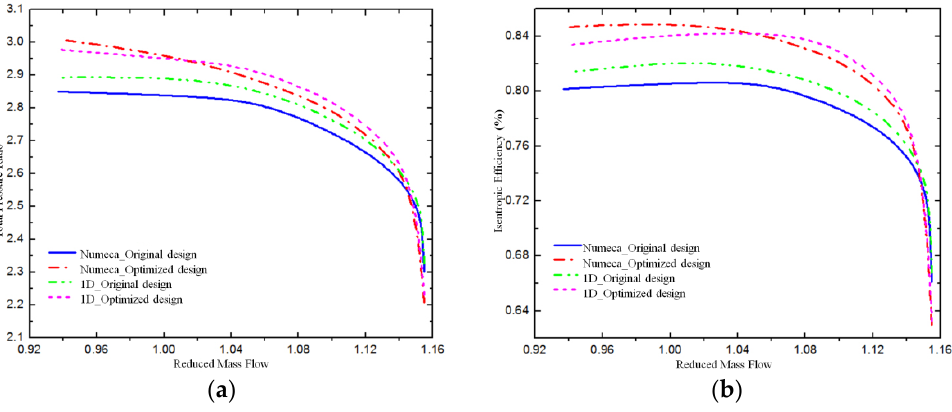
Figure 11. Performance map of the original and optimized designs for the high-pressure stage: ( a ) Reduced mass flow vs. total pressure ratio; ( b ) Reduced mass flow vs. isentropic efficiency.